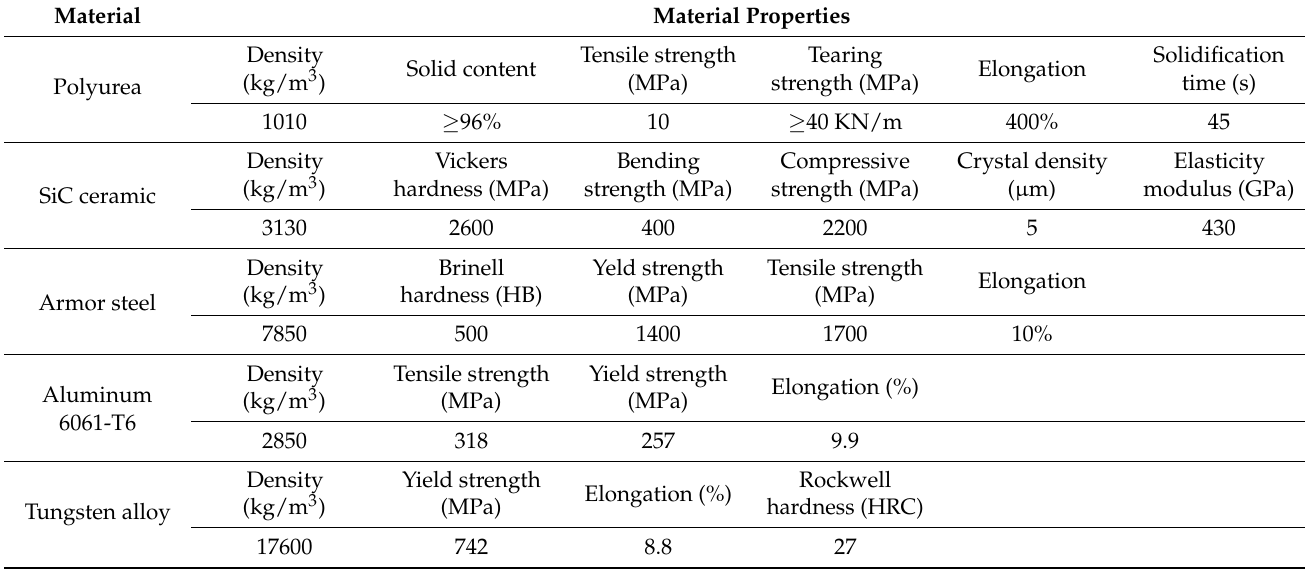
Table 1. Material properties.